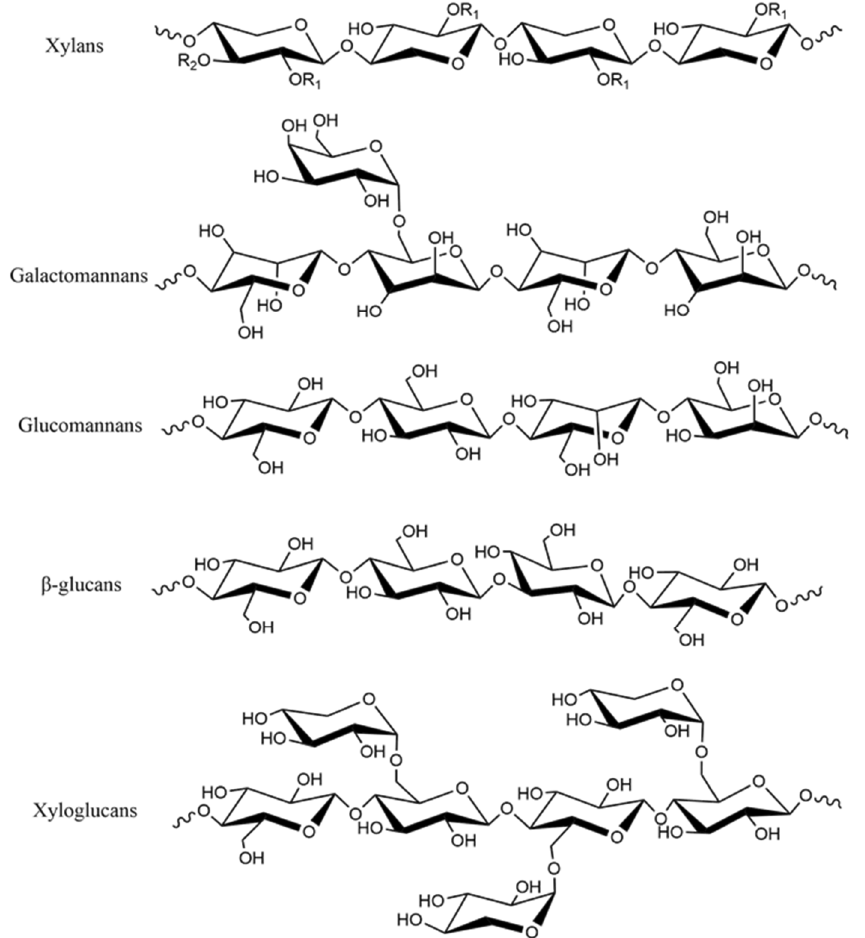
Figure 2. Primary structures of representative hemicellulose. With R1 and R2 are H or different side groups.